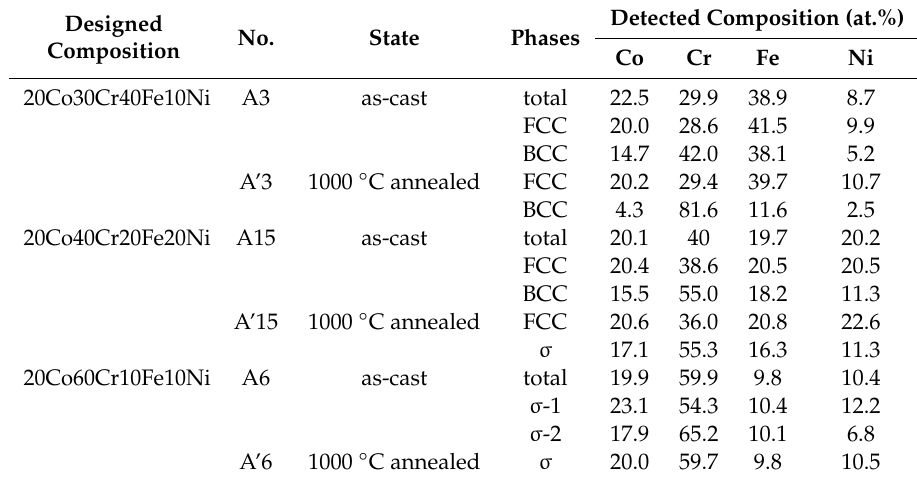
annealed Table 2. The detected chemical composition of the alloys A3, A6, and A15 in both as-cast and 1000 °C annealed states.